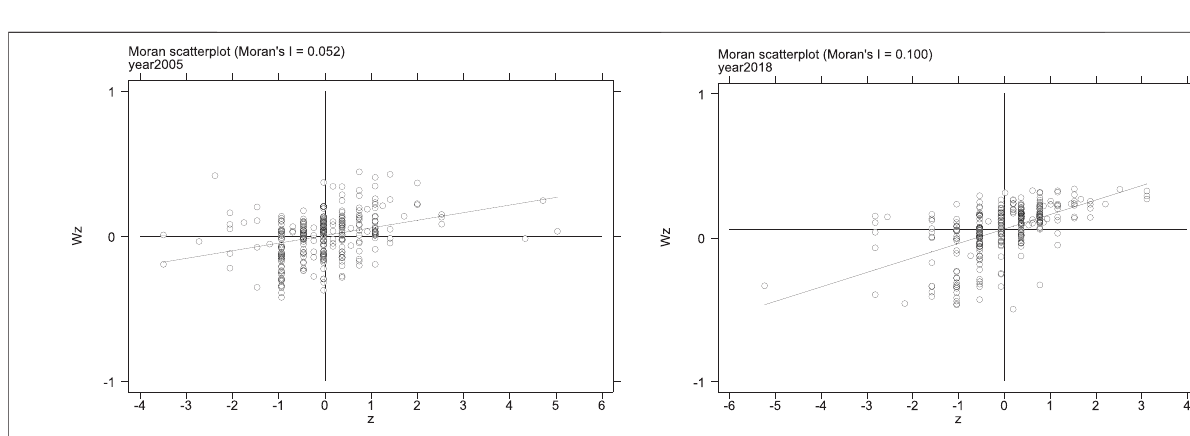
Frontiers in Environmental Science |